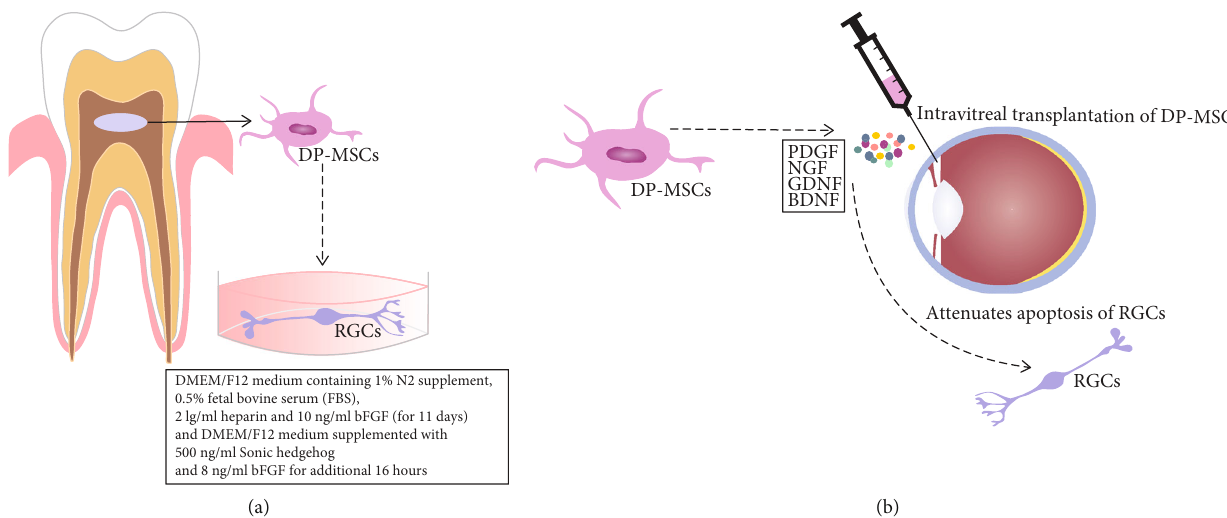
Figure 2: Therapeutic potential of DP-MSCs in glaucoma treatment. Dental pulp represents valuable and easily accessible sources for DP- MSCs which are able to di ff erentiate into functional retinal ganglion cells (RGCs) under appropriate culture conditions (a). Intravitreally transplanted DP-MSCs produce several neurotrophic factors (platelet-derived growth factor (PDGF), nerve growth factor (NGF), brain- derived neurotrophic factor (BDNF), and glial cell line-derived neurotrophic factor (GDNF)) which promote survival of RGCs and induce regeneration of injured axons